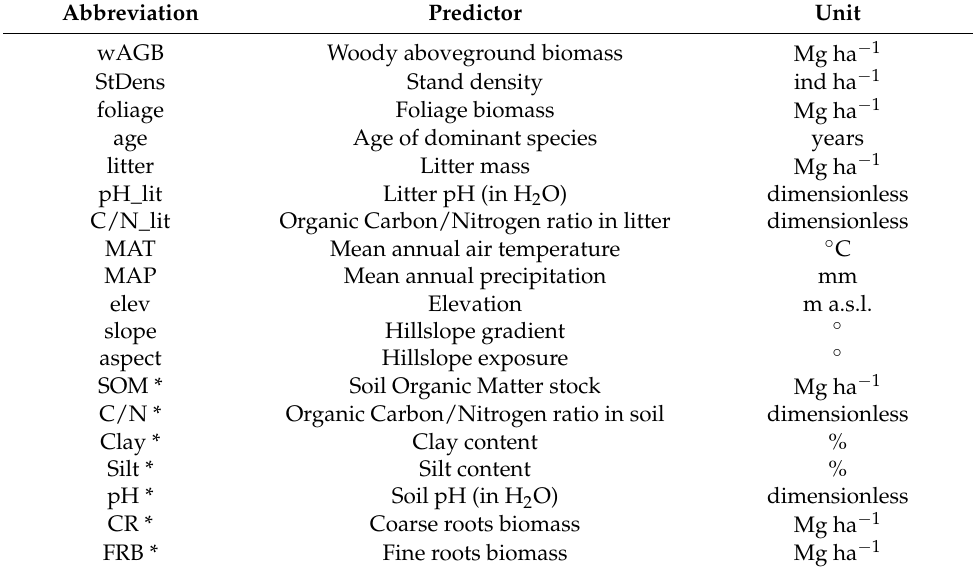
Table 2. List of